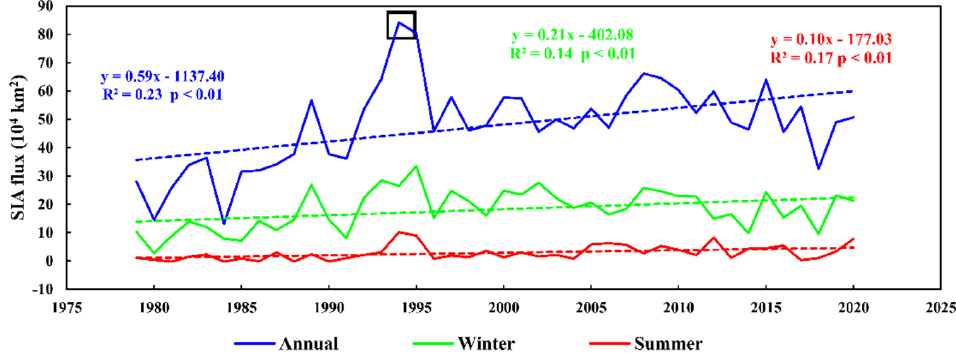
Figure 10. The annual and seasonal SIA outflow through the Fram Strait in 1979–2020. The black polygon indicates the time with the largest SIA export.